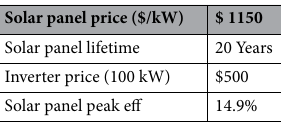
Table 2. Specification of VPP components.